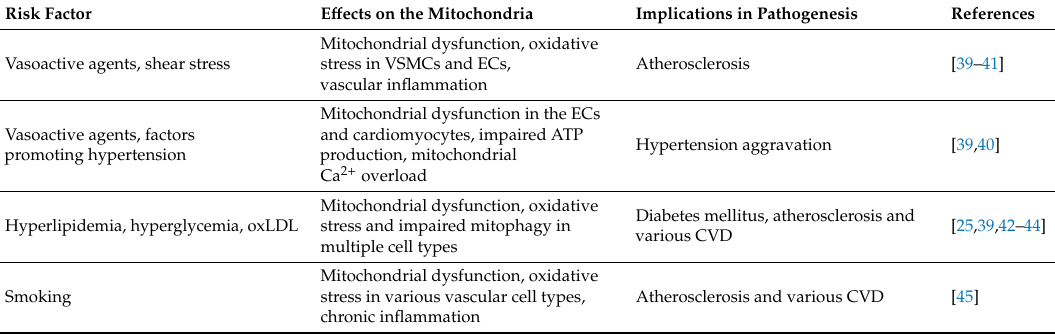
Table 1. Risk factors of cardiovascular disease and mitochondrial